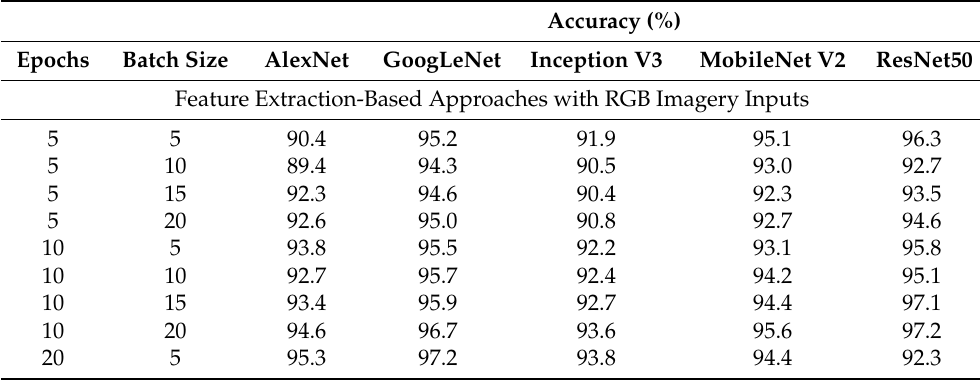
Table 5. Training accuracies of feature extraction-based models to characterize wheat water stress using RGB and thermal imagery inputs under different epoch and batch size